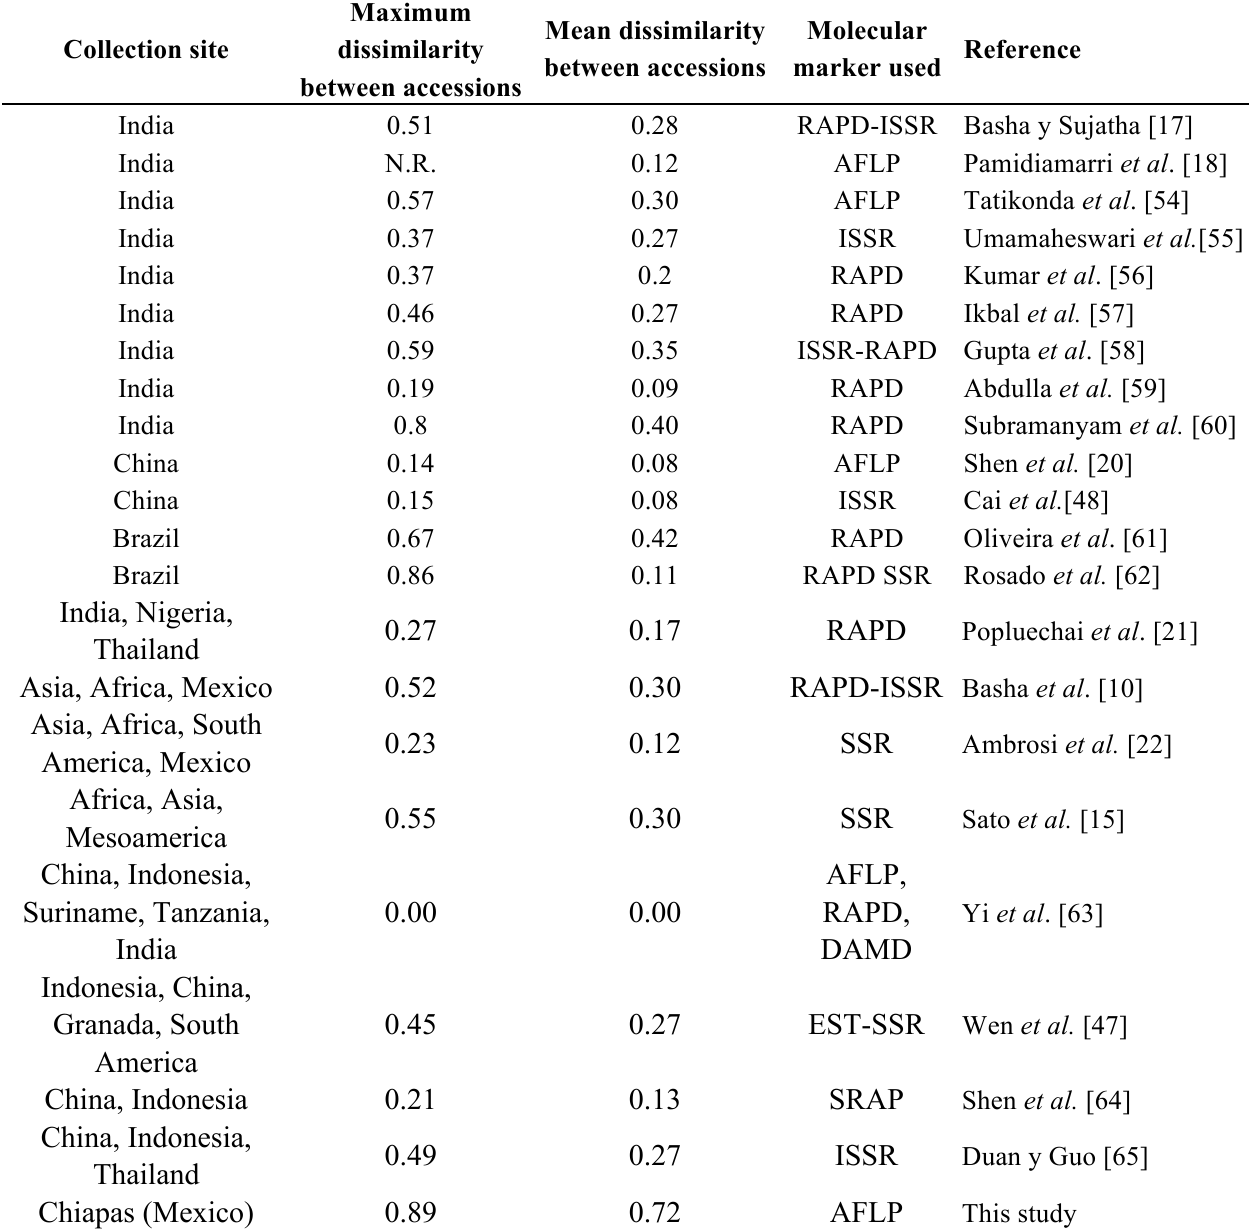
Table 3. Comparison of genetic variation in Jatropha curcas collected in different parts of the